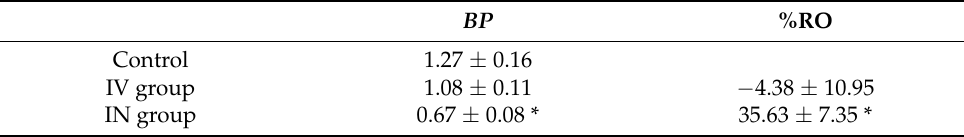
Figure 5. Specific binding of the striatum in the control, IV, and IN groups. Values are significantly lower in the IN group for about 20 min after intravenous [ 123 I]IBZM administration compared with the control and IV groups.* p < 0.05 between control and IN groups. Table 2. Mean BP and %RO values in the equilibrium state in control mice and in the IV and IN groups.